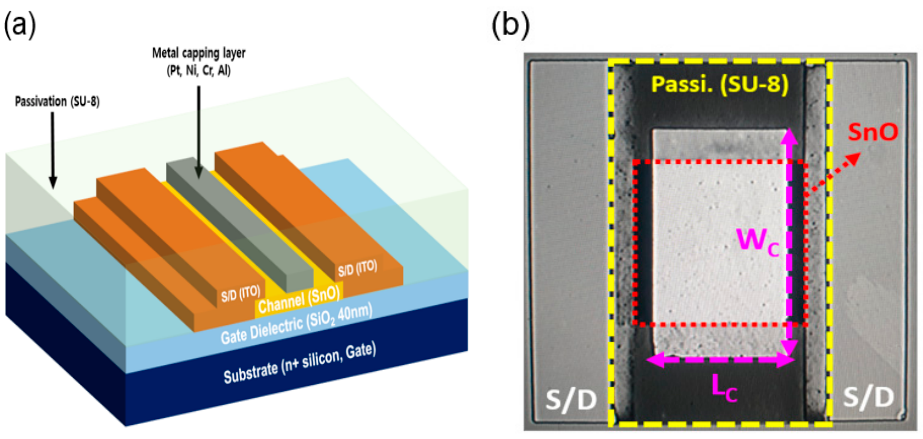
Figure 1. ( a ) Cross-sectional schematic view; ( b ) optical image of the fabricated p-channel SnO thin-film transistors (TFT) with a metal capping layer.